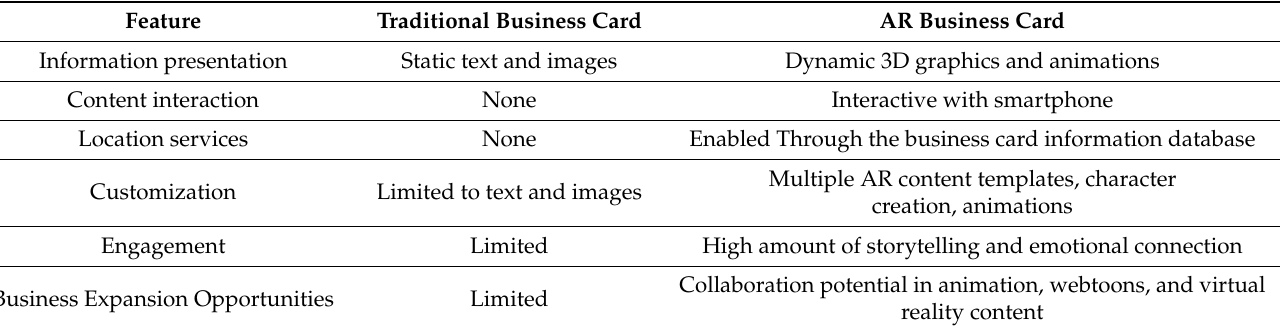
Table 1. Comparison of Traditional Business Cards and Augmented Reality Business